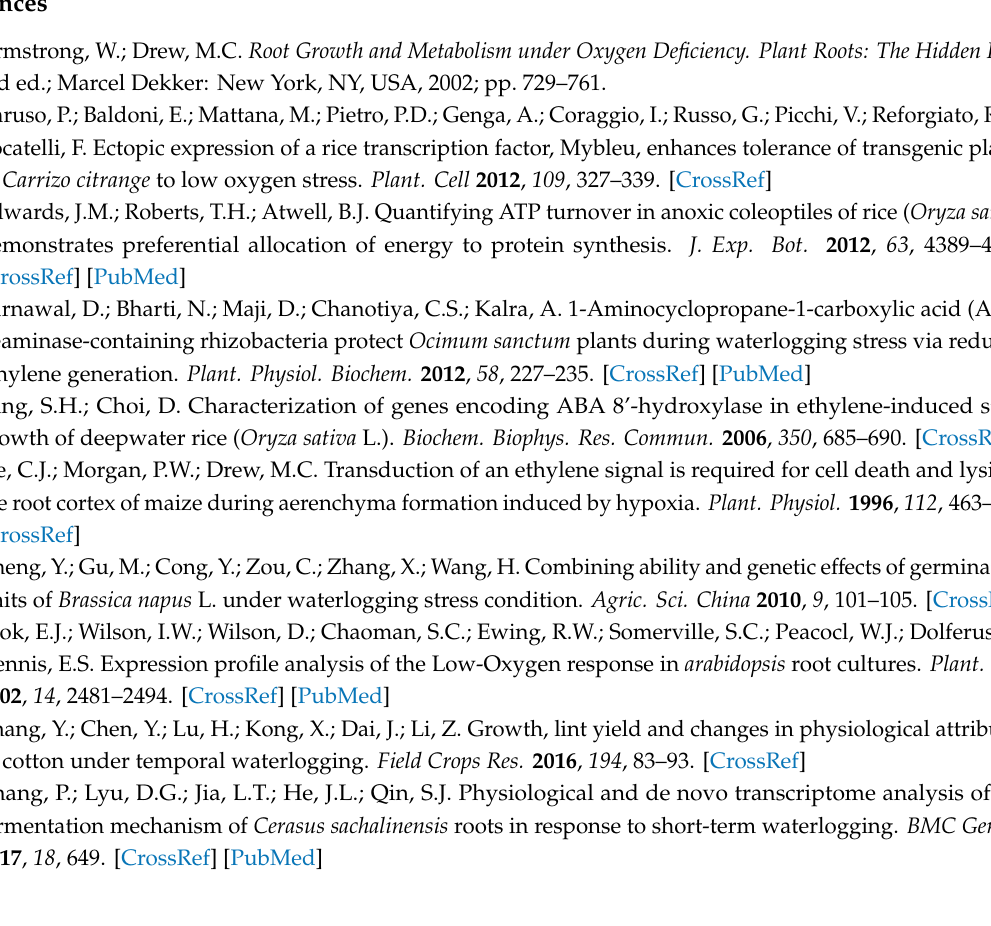
Table S1: qRT-PCR and cloning primers used in this study, Supplemental Data 1: Protein sequences for phylogenetic and cluster analysis of ERF TFs with conserved N-terminal motif (MCGGAI / L) in Arabidopsis, rice and barley, Supplemental Data 2: Protein sequences for phylogenetic and cluster analysis from Hordeum vulgare and other plant